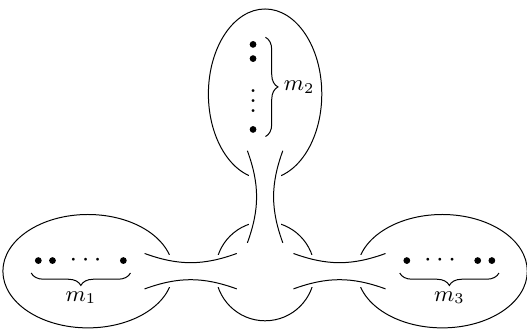
Figure 10 . The decomposition of the punctured sphere corresponding to the S -dual description of L (1) shown on the left of (cid:12)gure 9. The i -th tail contains m i (simple) punctures and corresponds to 1 ;n; 1 L (1) . The three cylinders correspond to SU( m i ) vector multiplets. The middle sphere corresponds 1 ;m i to T ( m 1 ;m 2 ;m 3 )